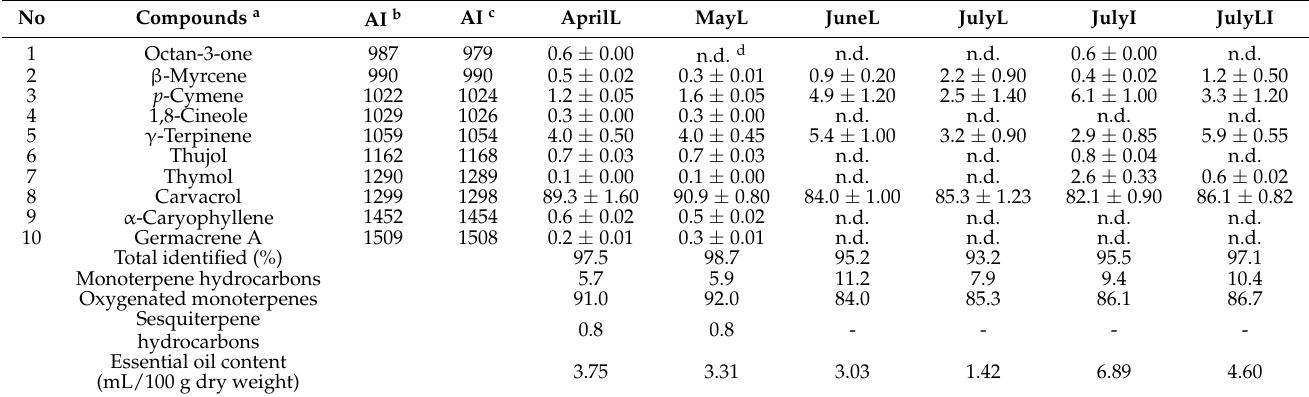
Table 5. Qualitative and quantitative composition of the Essential oils from O. vulgare subsp. hirtum collected from the field.